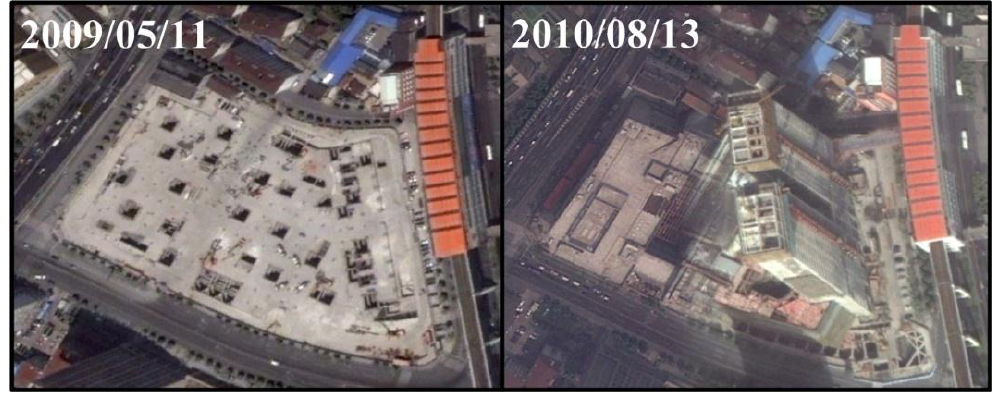
Figure 10. The two high-resolution optical image patches acquired on 11 May 2009 and 13 August 2010, respectively, over the area indicated by the rectangle in Figure 9. The image patches are obtained from Google